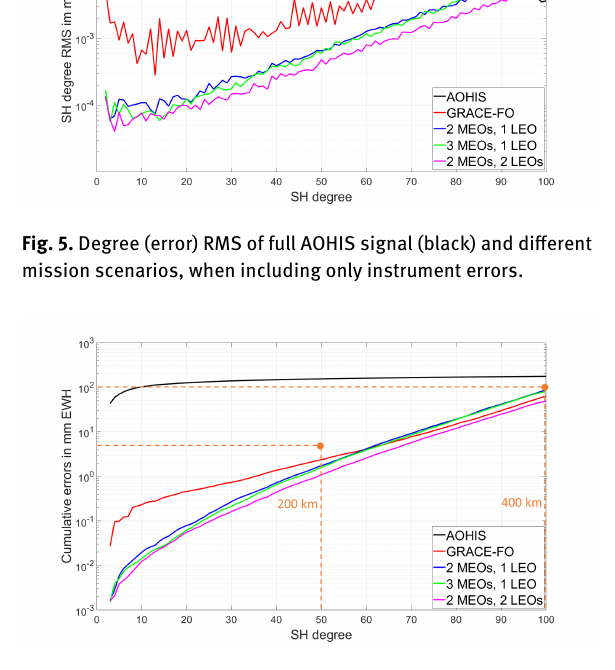
96 for the configuration 2 MEOs/1 LEO. As a reference, a GRACE-FO scenario is included (red curve), showing that MOBILE, even in the minimum configuration, will outper- form GRACE-FO by a factor of 5 in terms of mass transport observations.